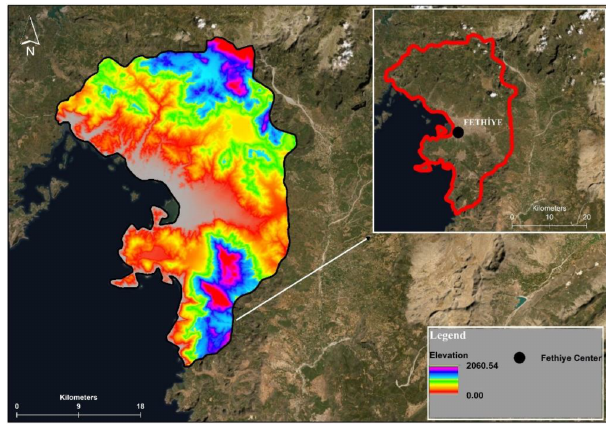
Figure 7. Demonstration of the DEM of study area (sources: Esri, Maxar, GeoEye, Earthstar Geographics, CNES/Airbus DS, USDA, USGS, AeroGRID, IGN, and the GIS User Community).